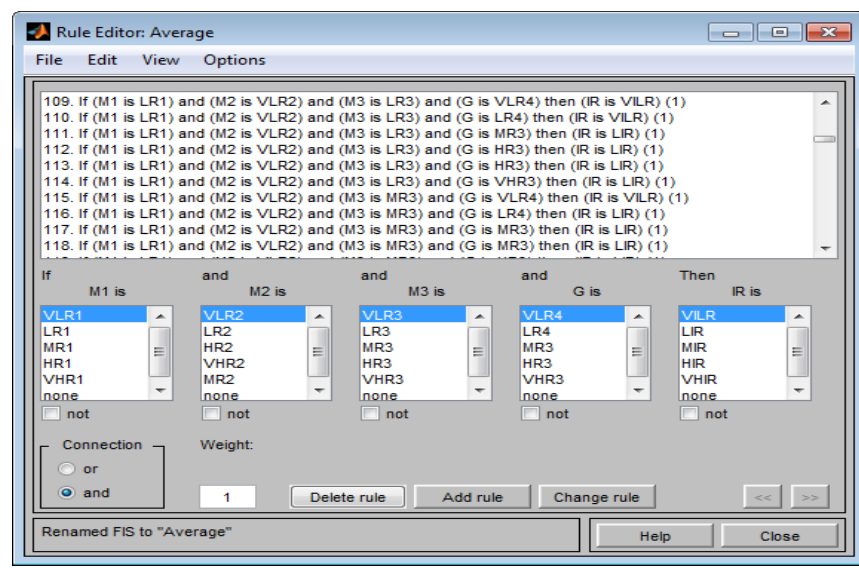
Figure 12. Rule editor A RB rule specification.